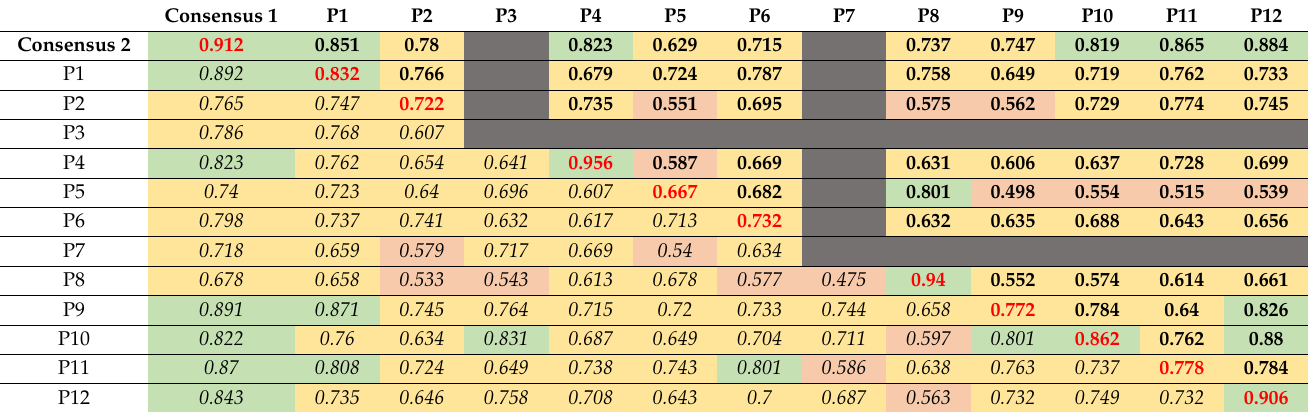
Table 6. Inter- and intra-observer agreement for all scoring